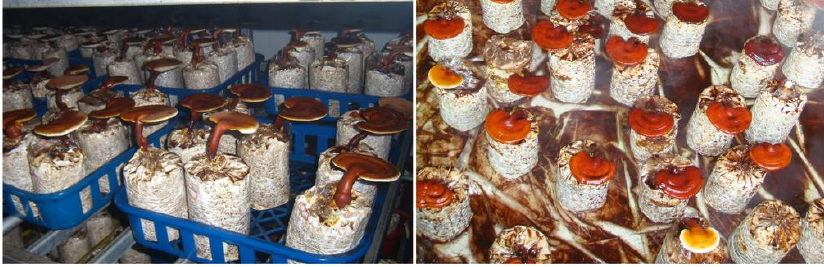
Figure 3. Fruiting of the 1st, 5th, 10th and 15th generations of the mutagenic strain UV119.